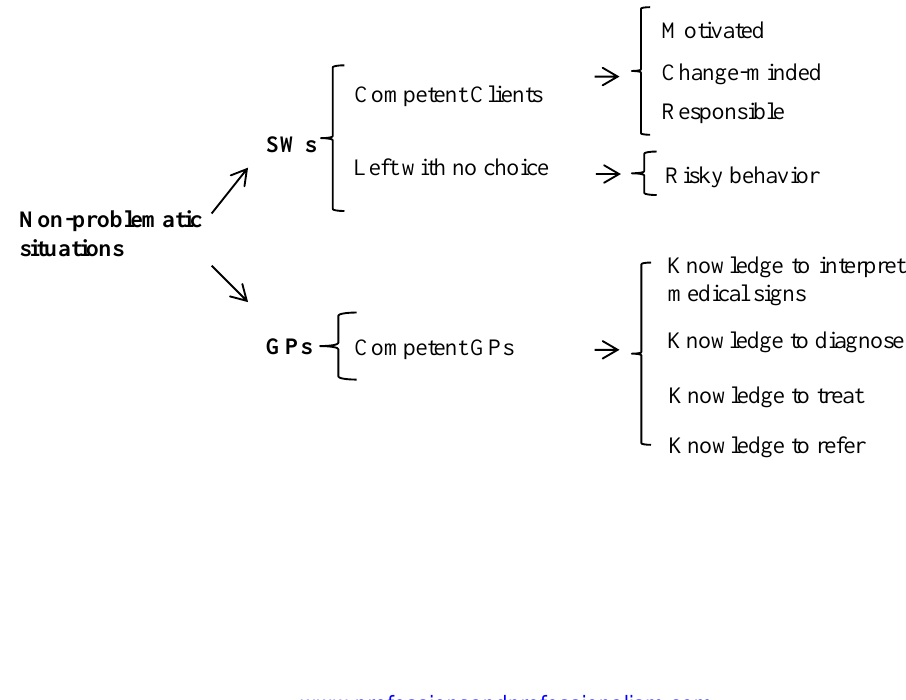
Competent Clients SWs Left with no choice Competent GPs